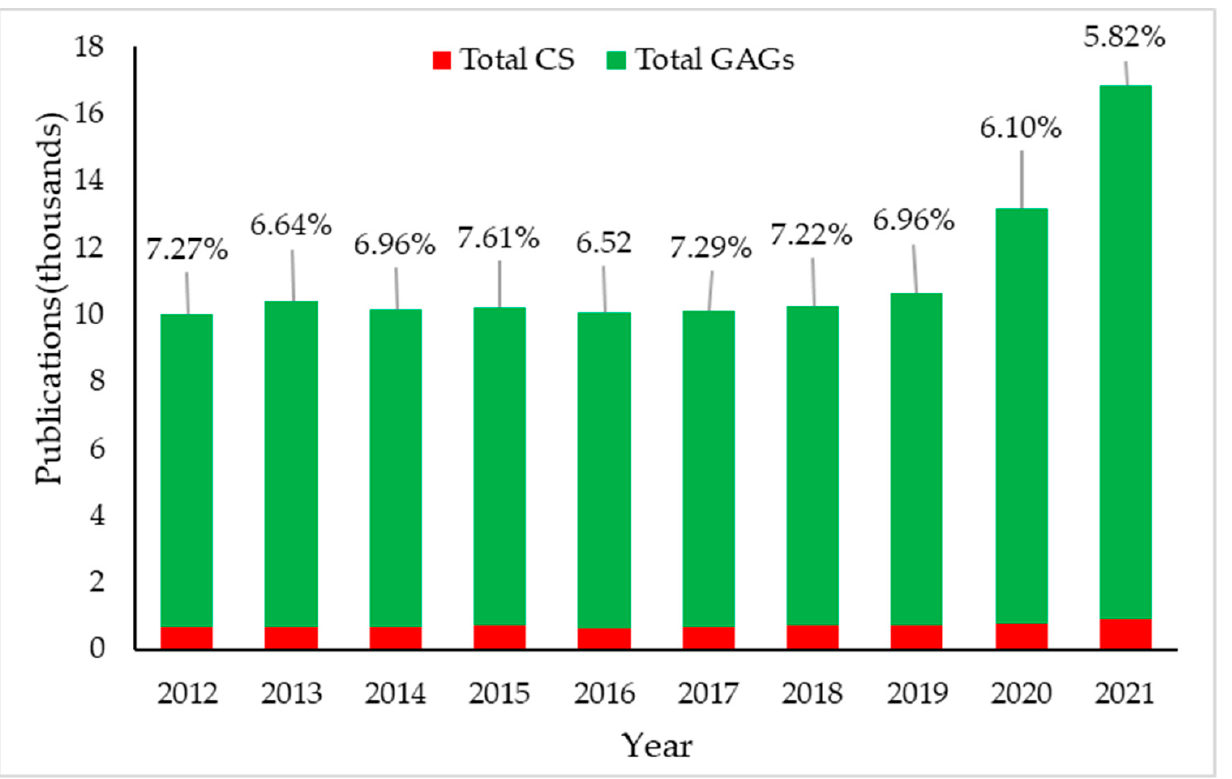
Figure 2. Annual publication statistics on scientific studies on Chondroitin sulphate (CS) from 2012 to 2021 in the Scopus database. The % value on the top of the bar graph shows the number of CS publications against the total glycosaminoglycans (GAGs) publications.